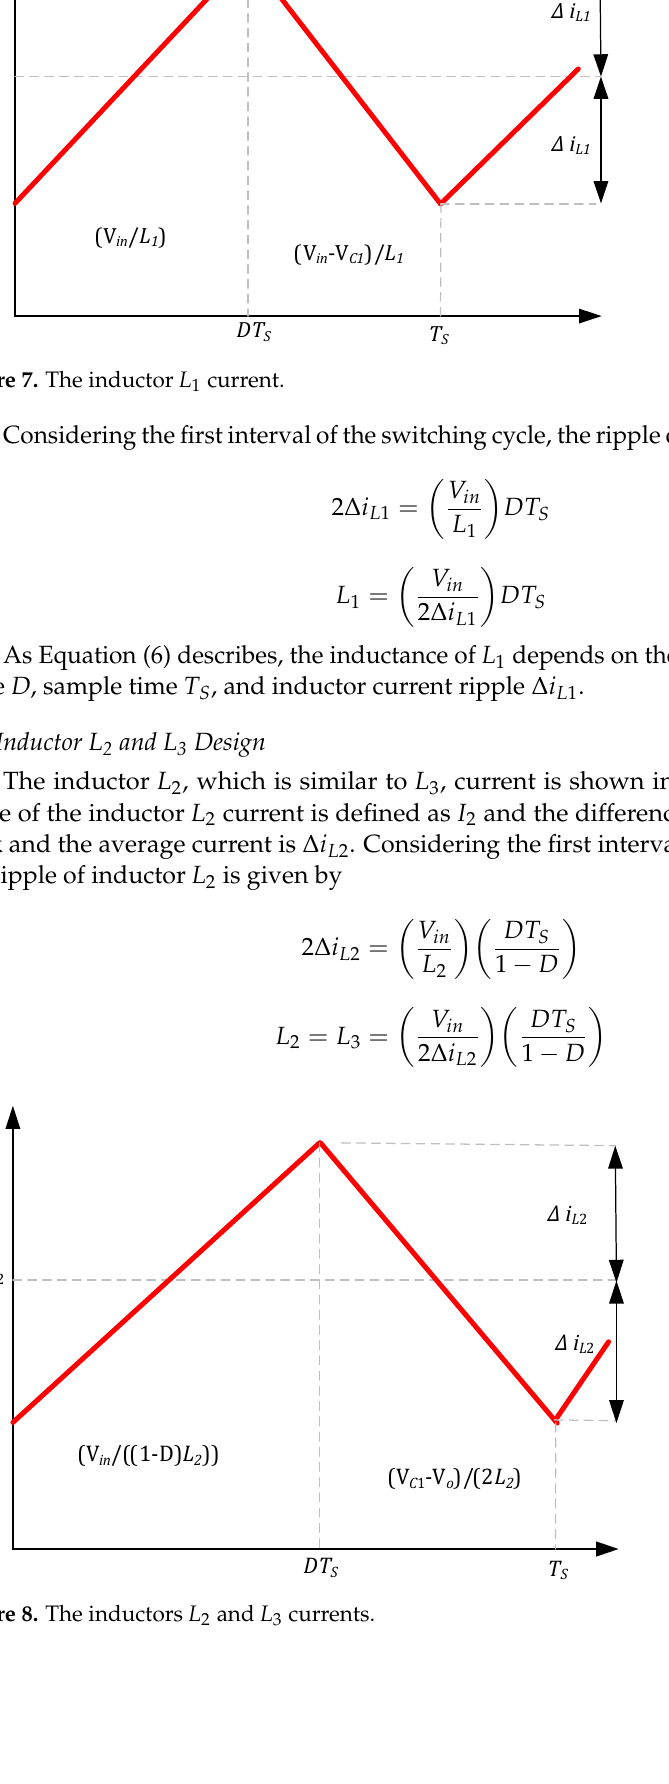
Figure 8. The inductors L 2 and L 3 currents.